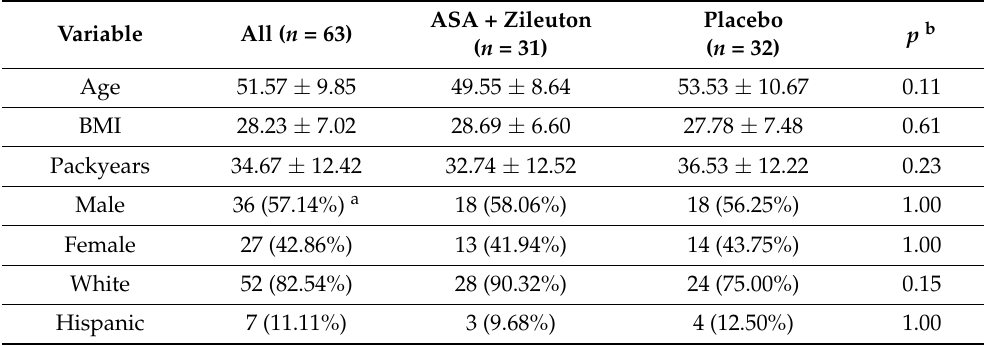
Figure 1. Consort flow diagram. Table 1. Baseline characteristics of the randomized participants; data is presented as mean ± standard